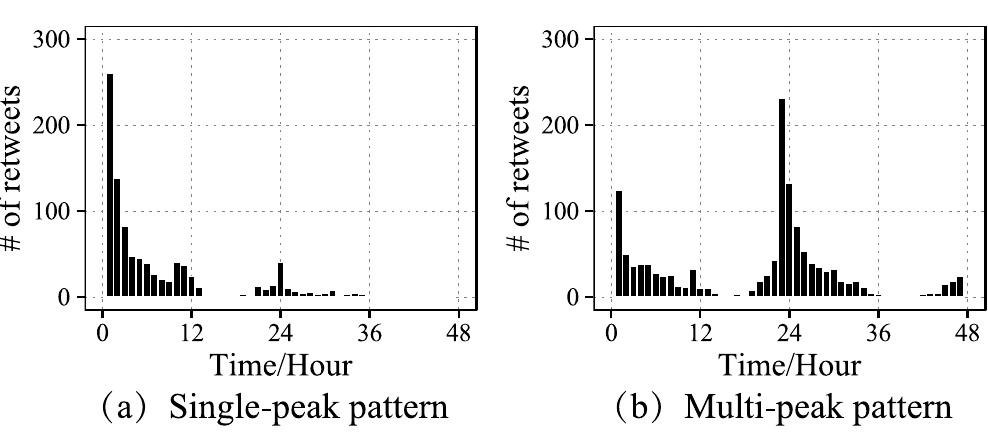
Figure 2. Single-peak and multi-peak patterns of retweeting